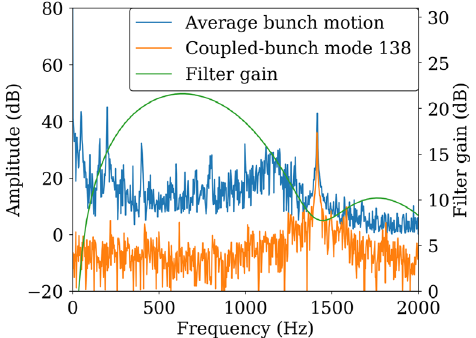
FIG. 6. Threshold Landau-cavity voltage for different fill patterns in the MAX IV 3 GeV ring and calculation of the same for the example HOM and for the HOM shifted in frequency so that it drives coupled-bunch mode 138 when the fill pattern is